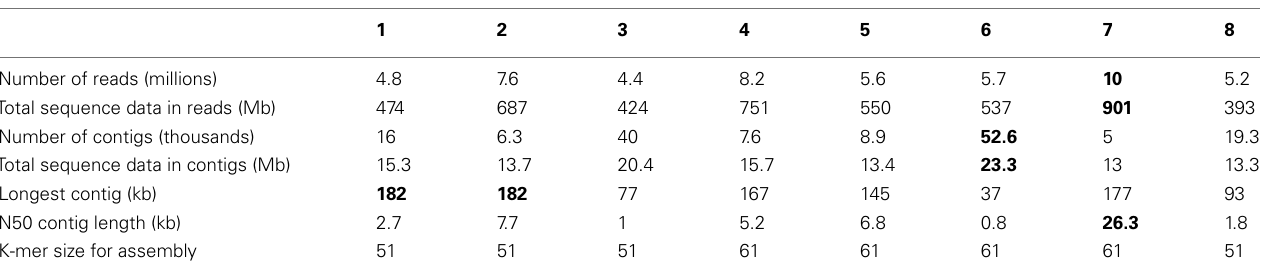
Table 2 |Assembly results of the eight sequenced metagenomes.